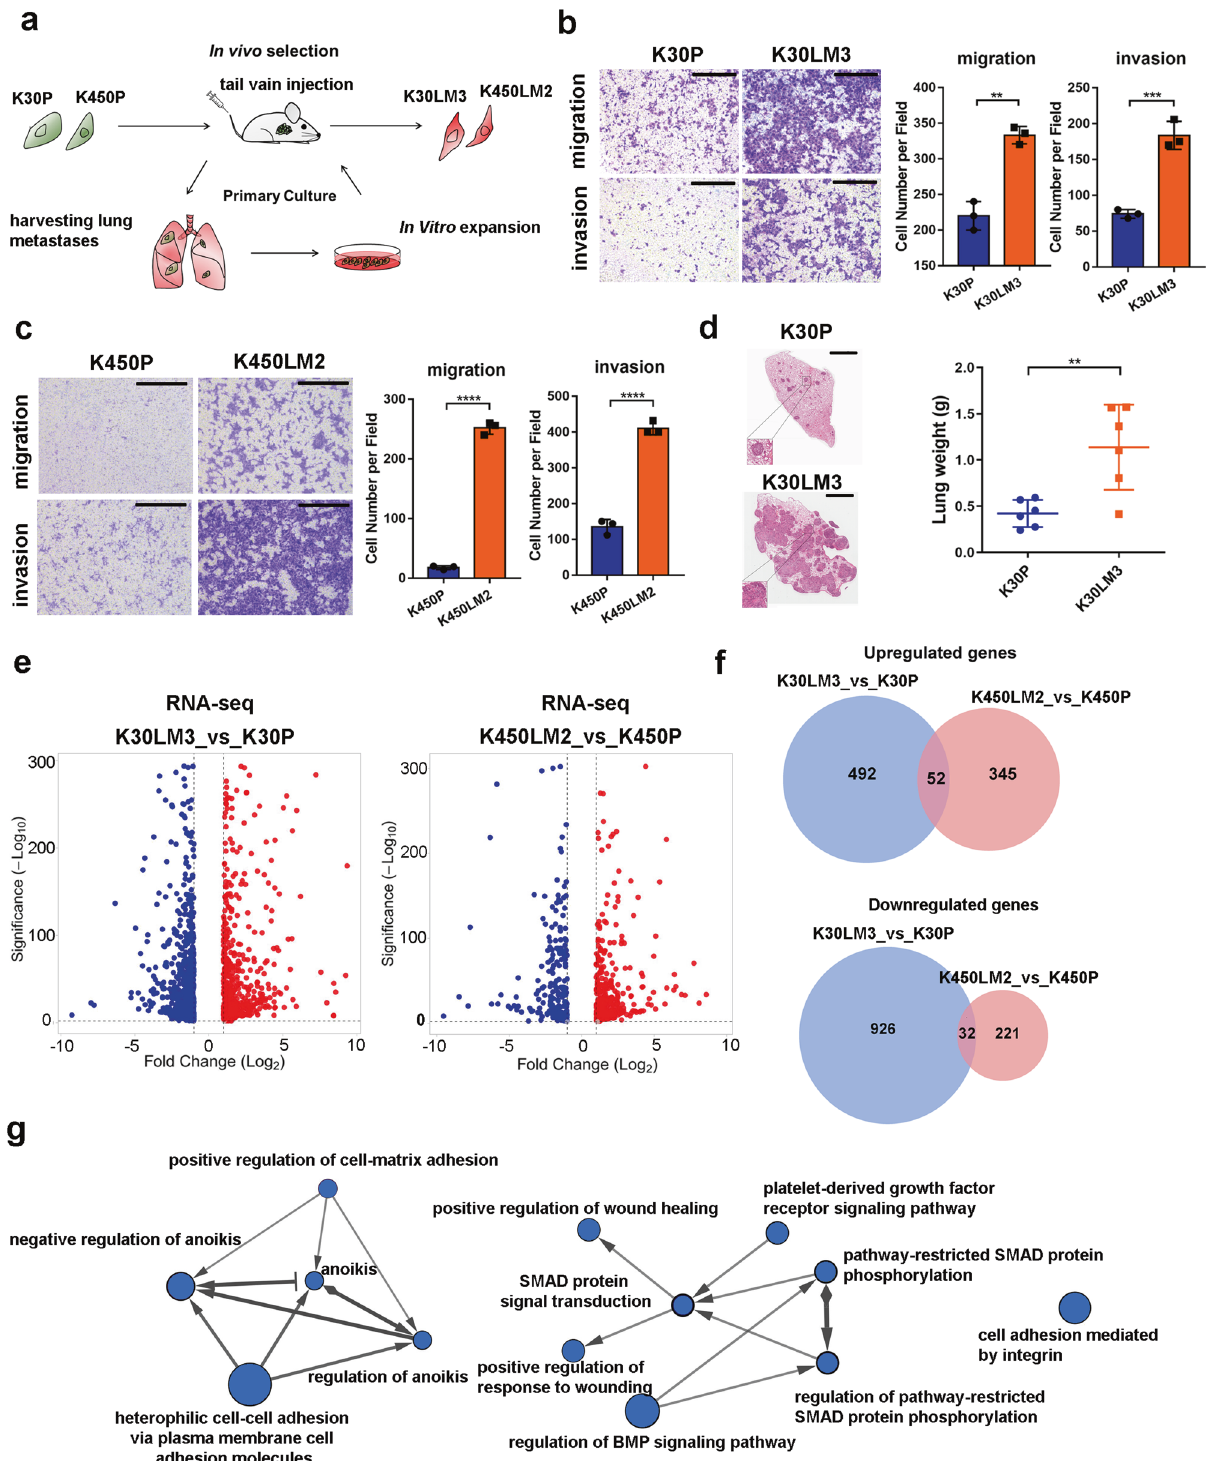
Fig. 1 The selection of ESCC cells with high metastatic potential. a Schematic showing establishment of highly lung metastatic ESCC sublines by in vivo selection. b , c Transwell assay was performed to compare the migration and invasion ability of K30P/K30LM3 cells ( b ) or K450P/ K450LM2 cells ( c ). Scale bar, 500 µm. d Representative H&E images of lung tissues harvested from K30P and K30LM3 tail-vain injected mice (left panel). Scale bar, 2 mm. Statistical analysis of lung weight in each group (right panel). e Volcano plot showing the differential expressed genes between K30P and K30LM3 (left panel) or K450P and K450LM2 (right panel) cells by RNA-seq analysis (false-discovery rate (FDR) < 0.05, fold-change > 2). f Venn diagrams show upregulated and downregulated genes in LM cells relative to parental cells. g Cytoscape analysis shows the enrichment of metastasis related pathways in LM cells. The node size is proportional to the number of genes for each pathway term. Error bars denote mean ± SD. ** P < 0.01, *** P < 0.001, **** P < 0.0001